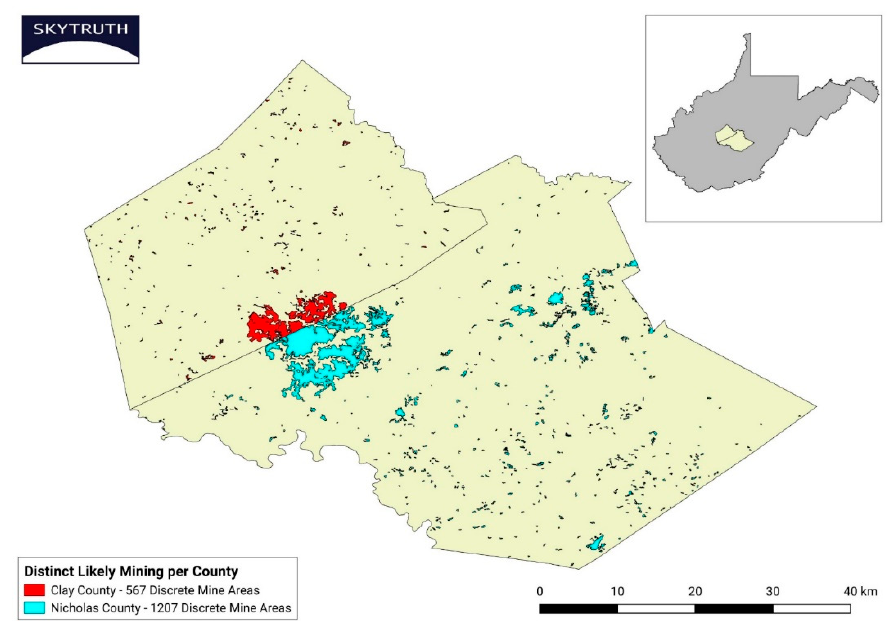
Figure 2. Distinct mining sites vs. km 2 mined. An illustration, courtesy of SkyTruth, demonstrating “km 2 mined” vs. “distinct mining sites” in Nicholas and Clay counties from 2000–2015. These composite images were created from multiple individual Landsat satellite images. As can be surmised from this composite, it is possible to have relatively little km 2 mined but still have a great number of individual mines and vice versa. The number of individuals ultimately exposed to particulate matter (PM) from MTM operations would vary depending on the location and extent of mining in that county and the distribution of populated areas.